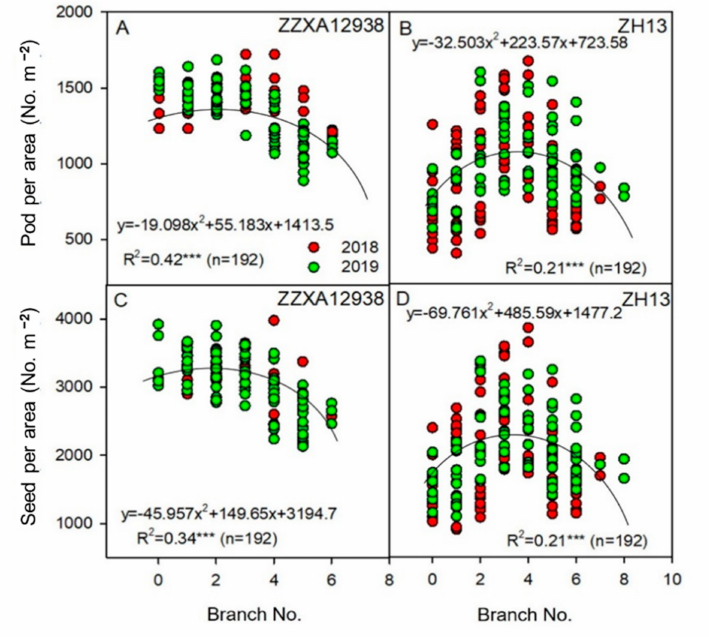
Figure 7. The relationship between the number of pods and seeds per unit area and the branch number for ( A , C ) ZZXA12938 and ( B , D ) ZH13. Markers with different colors represent different growing season; *** indicates that the correlation is significant at the p ≤ 0.001 level.